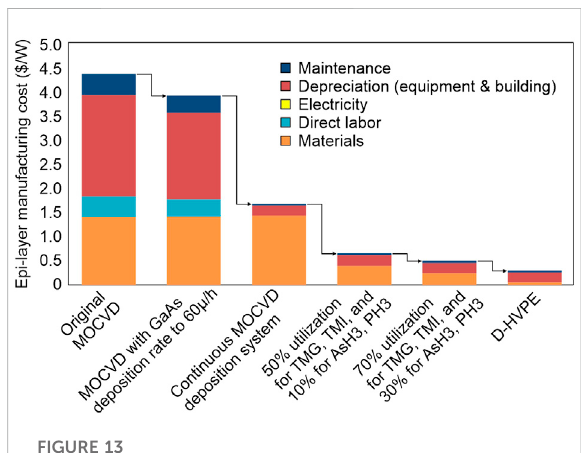
FIGURE 13 Effects of fabrication optimization (increased